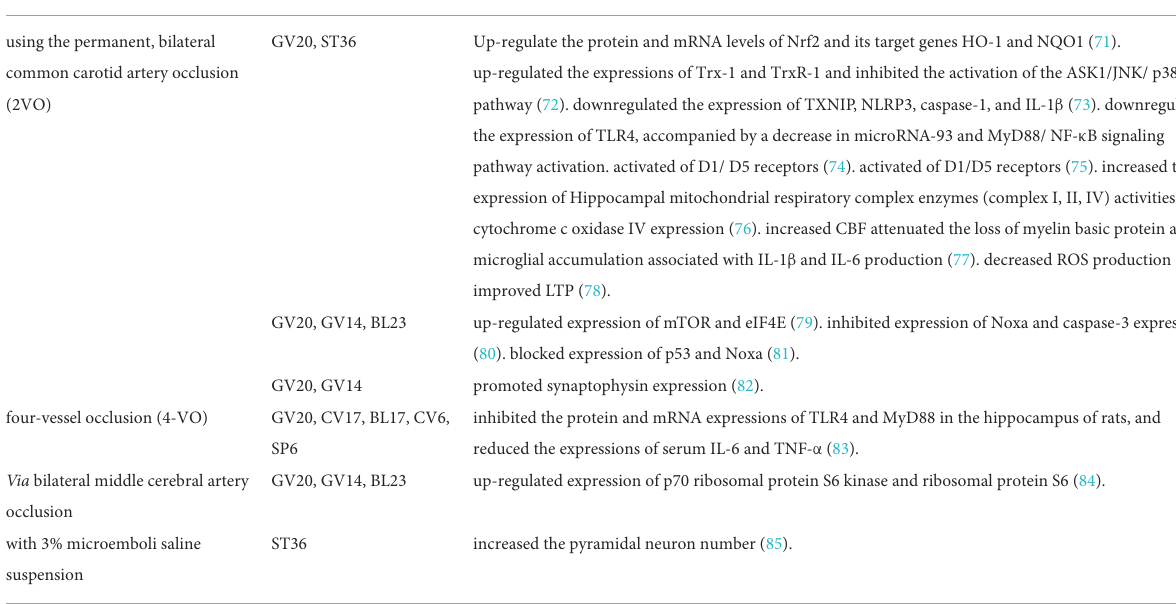
TABLE 7 Mechanisms of acupuncture on different vascular dementia animal models. Model Acupuncture point